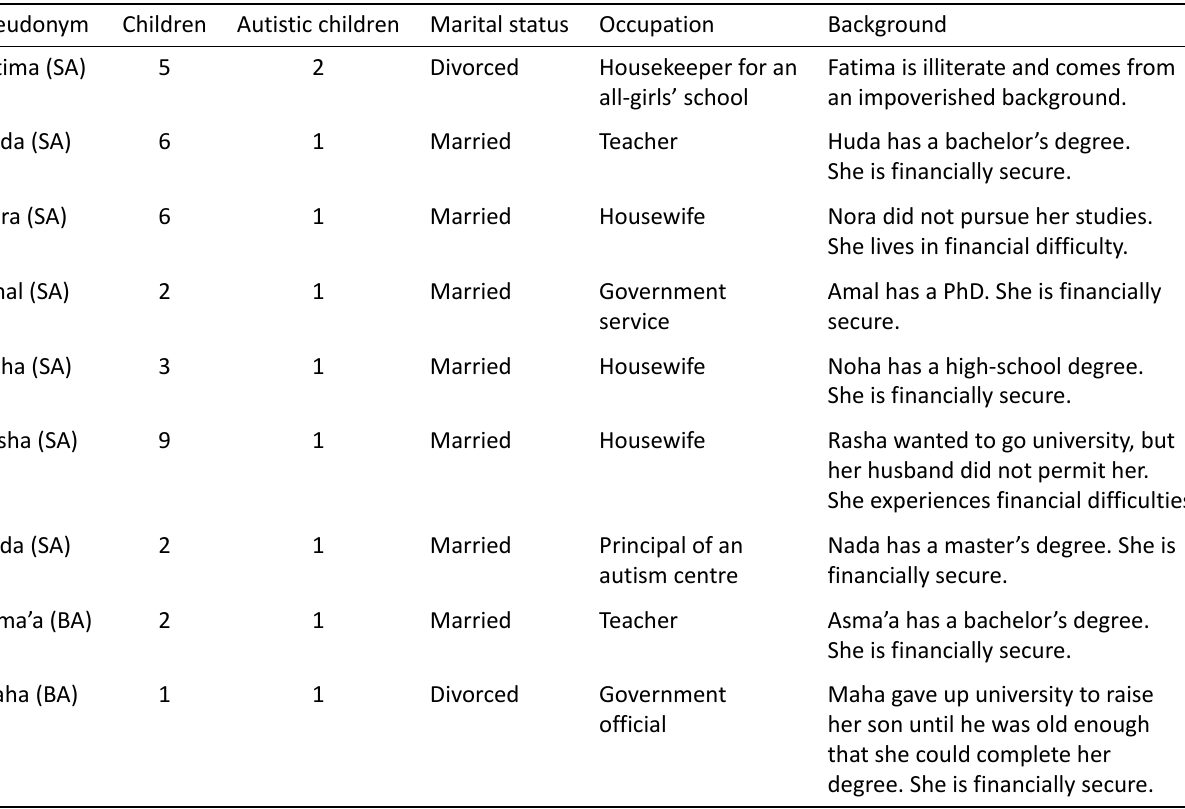
Table 1. Summary of participants’ biographical